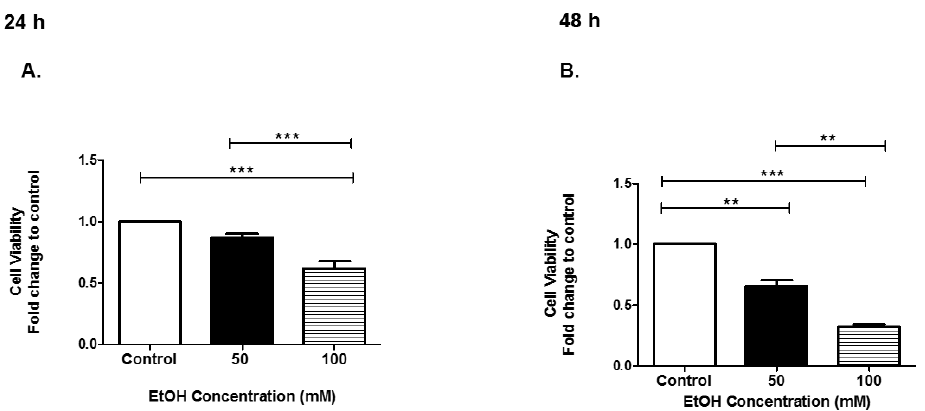
Figure 1. E ff ect of EtOH on HeLa cells. HeLa cells were treated with EtOH for ( A ) 24 h or ( B ) 48 h. At 24 h and 48 h, EtOH administration cell viability was assessed by the trypan blue exclusion assay. Data are presented as the means ± SEM of five independent experiments. Significance is defined as ** p ≤ 0.01, *** p ≤ 0.001.